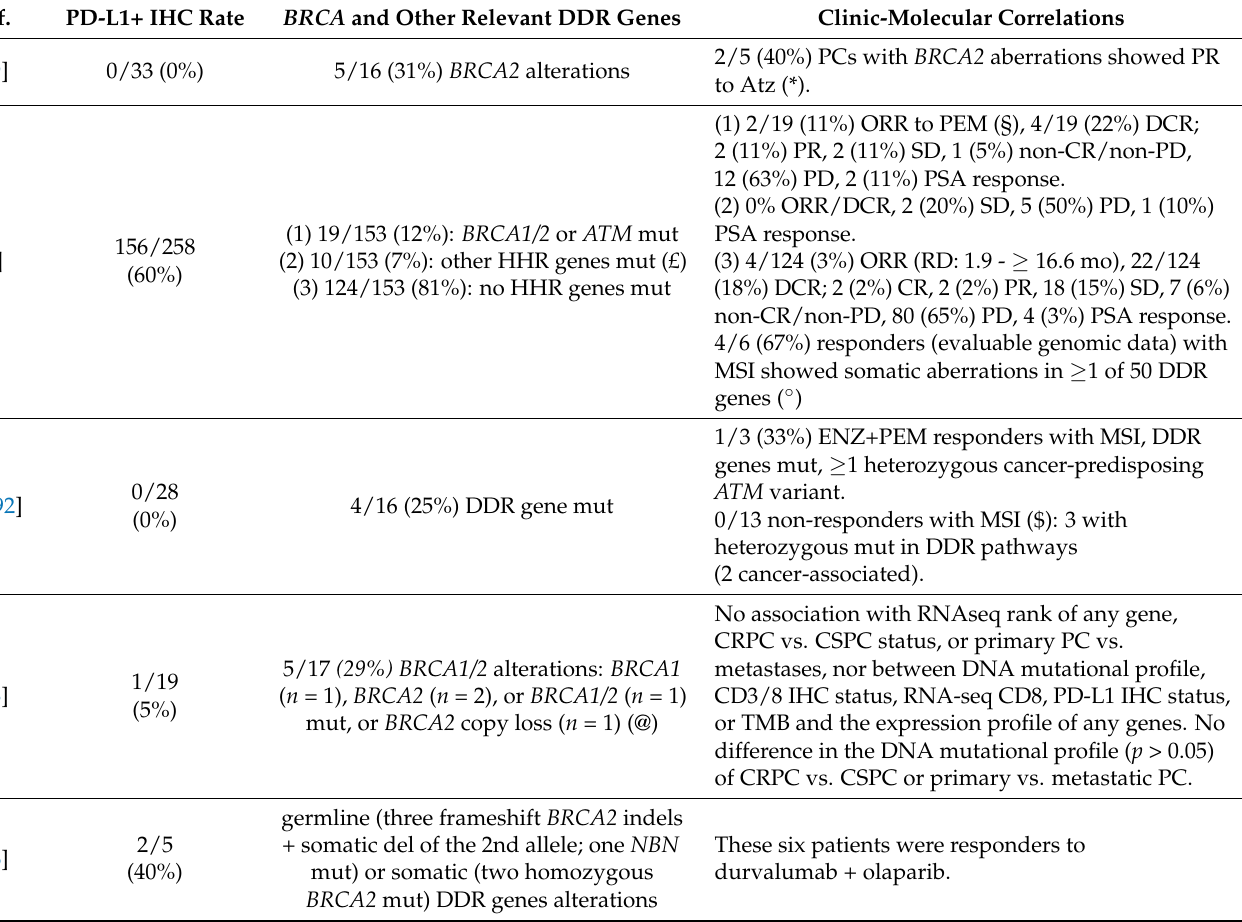
Table 2. PD-L1 expression and status of BRCA1/2 and other DNA damage repair genes in patients with prostate